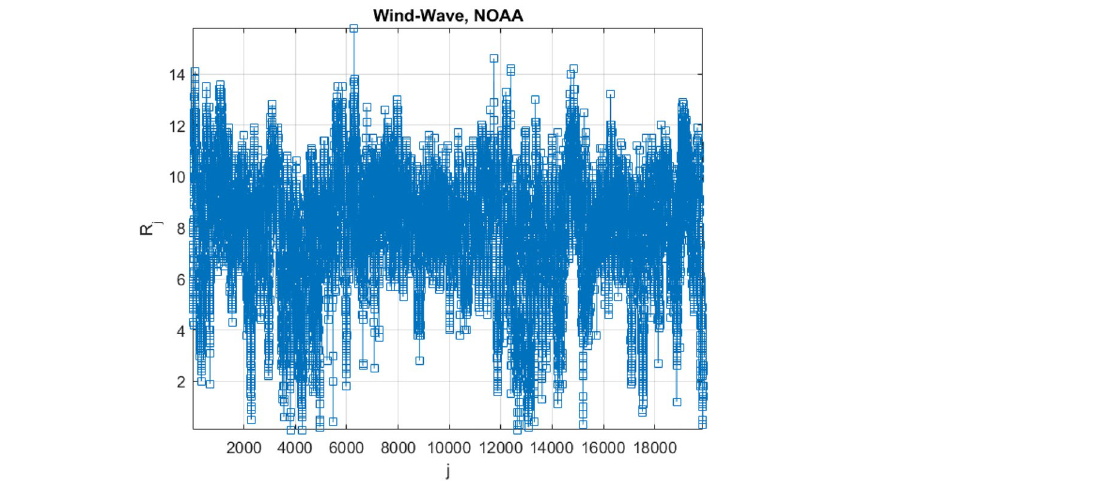
Figure 3. Scaled non-dimensional assembled 2D vector (cid:31) R